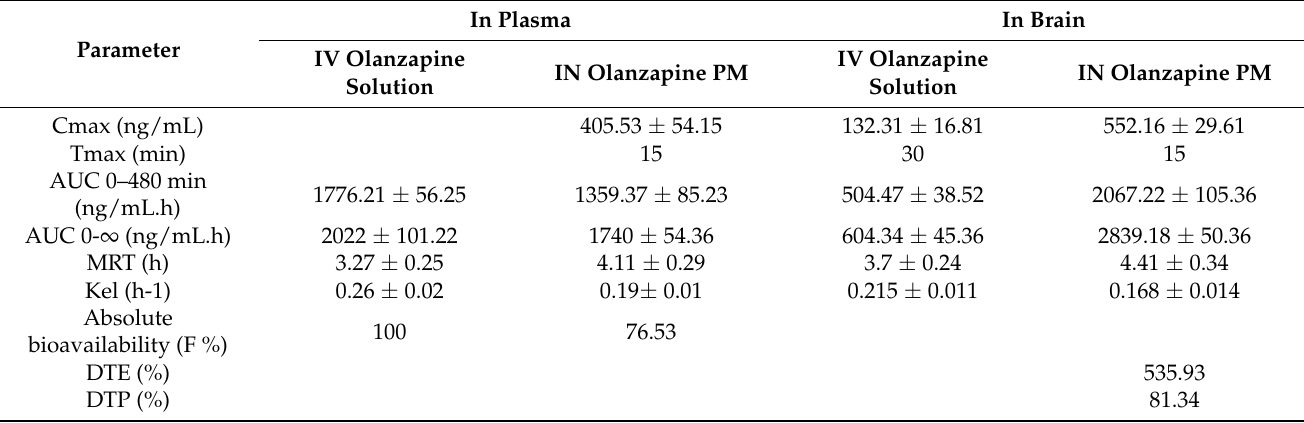
Figure 9. OZ concentrations in rats after administration of various formulations: ( A ) plasma concen- trations; ( B ) brain concentrations. Table 3. Pharmacokinetic parameters of intravenous olanzapine solution and intranasal polymeric